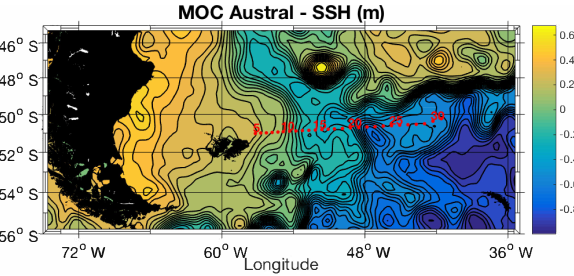
Figure 8. AVISO SSH for the MOC-Austral cruise. Isolines have a separation of 5cm.